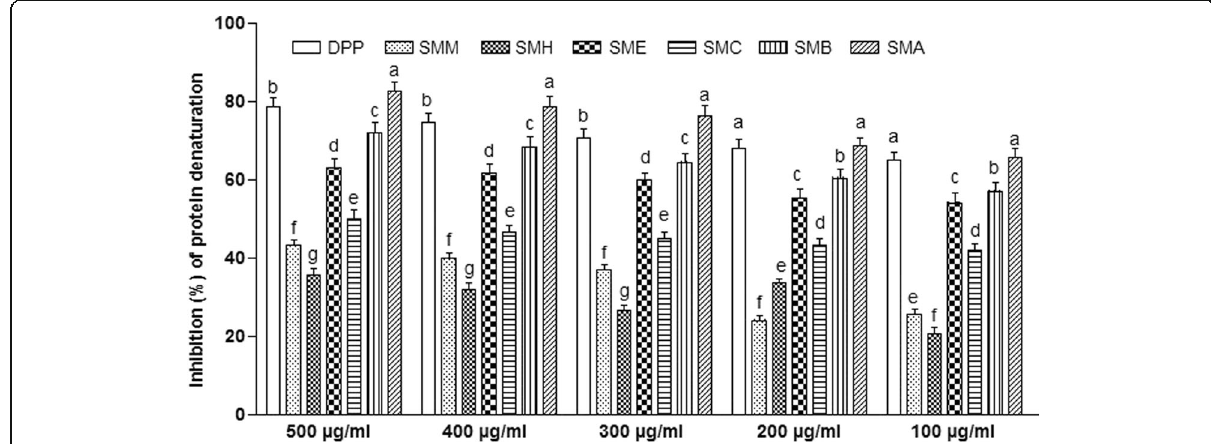
Fig. 3 Percent inhibition of protein denaturation at different concentrations of S. mukorossi extract/fraction. Each bar represents as Mean ± SD ( n = 3). Superscript ( a-f ) indicate significance for specific concentration at P <0.01. SMM, S. mukorossi methanol extract of stem bark; SMH, n- hexane fraction of SMM; SMC, chloroform fraction of SMM; SME, ethyl acetate fraction of SMM; SMA, soluble residual aqueous fraction of